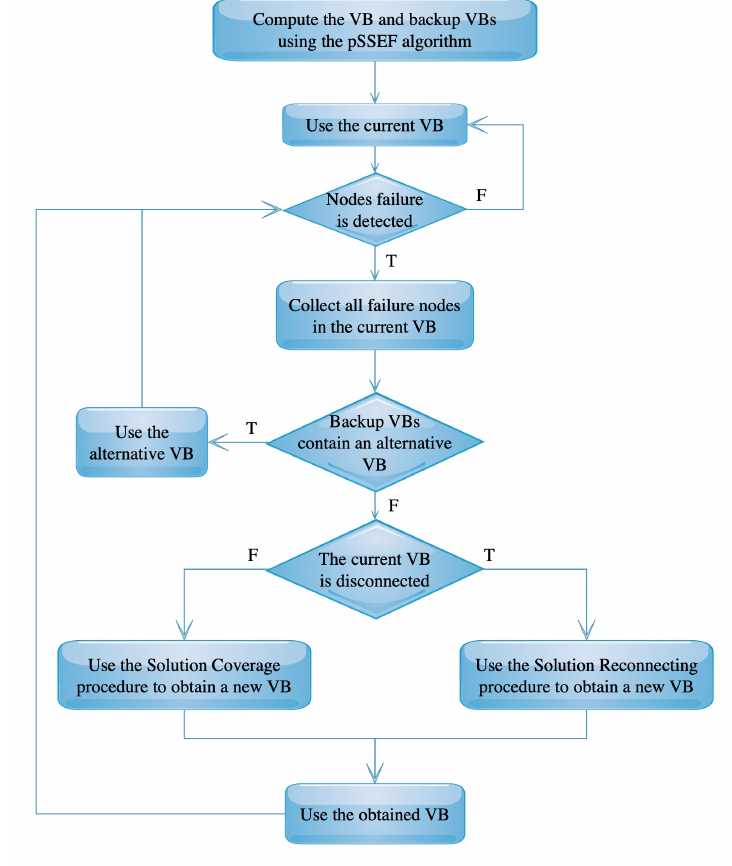
Figure 5. The FT-pSSEF